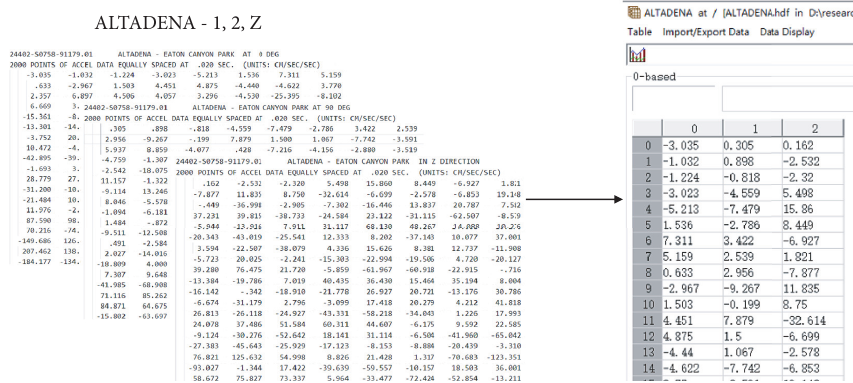
Figure 16: An example of transformed analytical data in